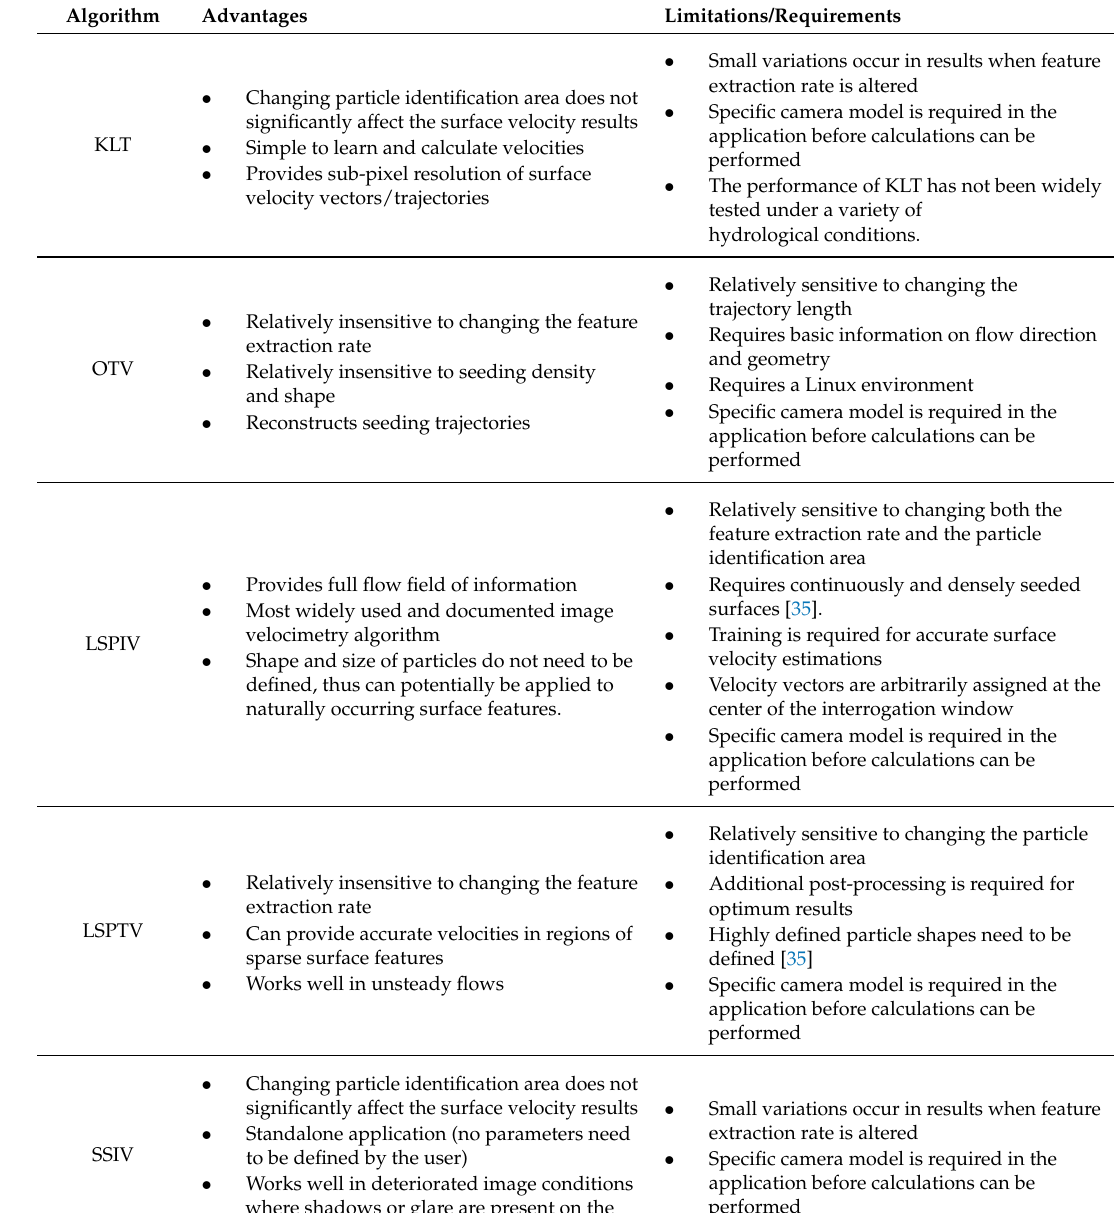
Table 6. Advantages and limitations of the five image velocimetry methods applied throughout this